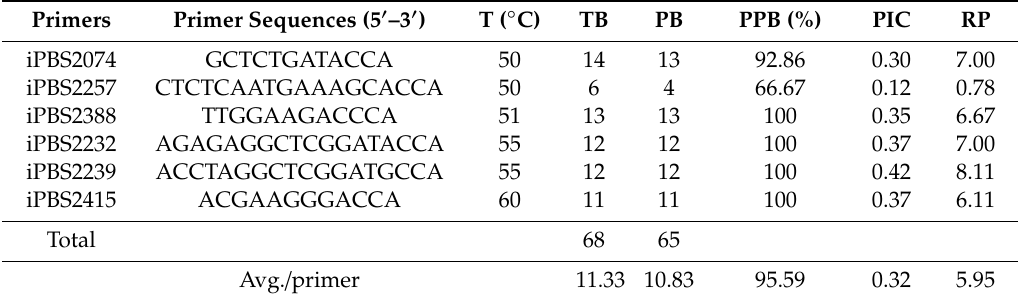
Table 6. List of iPBS primers used in the current study and their information.